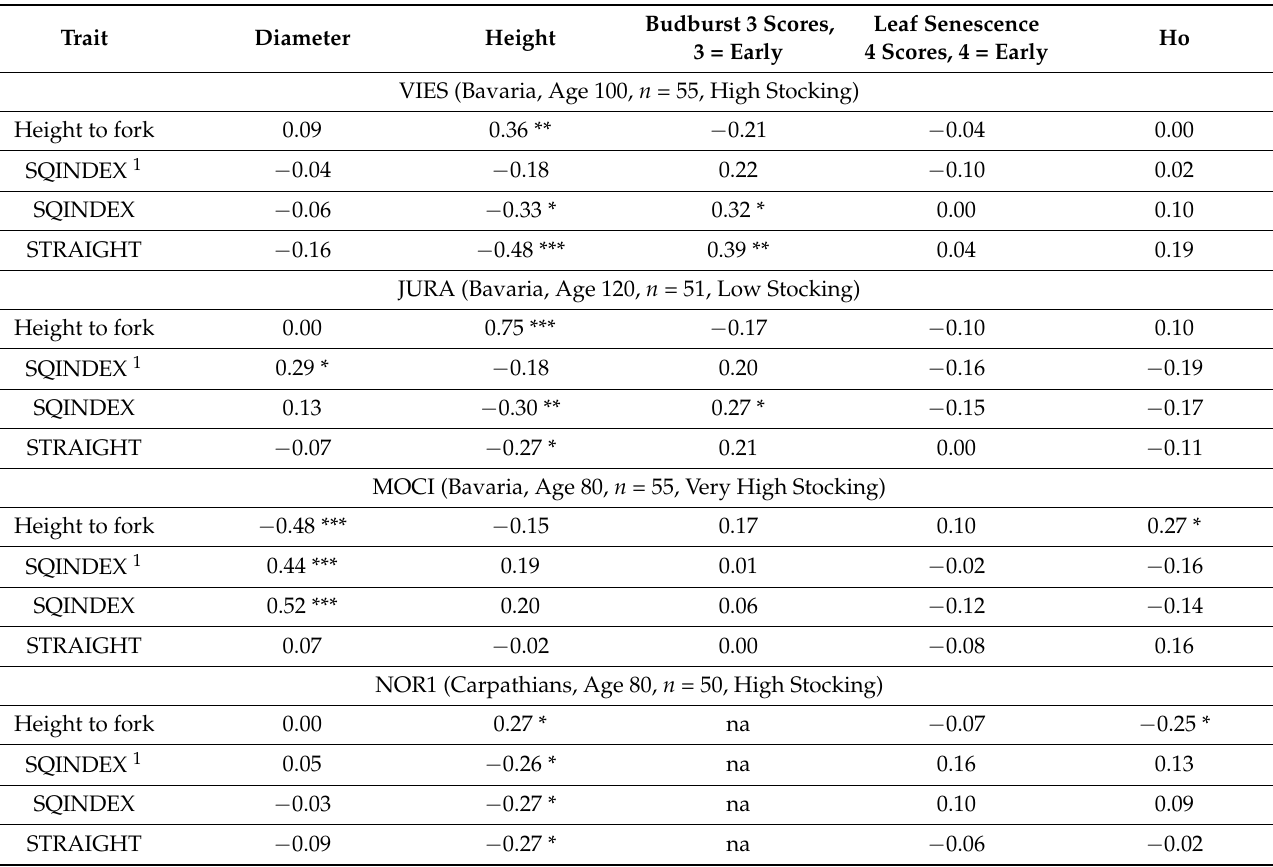
Table 3. Pearson product moment correlation coefficients and their significance (*-0.01 to 0.05, **-0.001 to 0.01, and ***-<0.001) among the morphology traits and observed heterozygosity (Ho) of European beech trees calculated separately in each of the studied stands. The origin, age, number of trees and stocking of the stands are given in the parathesis at their names. Ho is observed heterozygosity of individual tree. High value of the stem indexes and stem straightness indicates worse stem quality. Height to fork measures height from the ground to the first major stem fork moving from the tree base upwards. SQINDEX 1 is the stem quality index calculated without the stem straightness term in the formula.